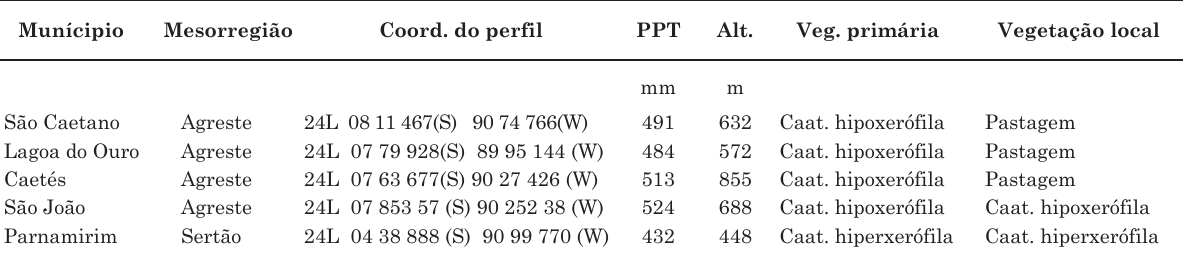
Quadro 1. localização e descrição simplificada dos locais dos perfis estudados